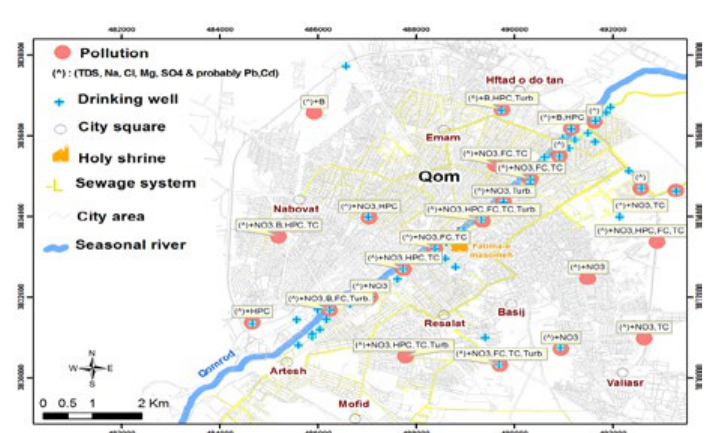
Fig. 9. Groundwater pollutants in Qom urban